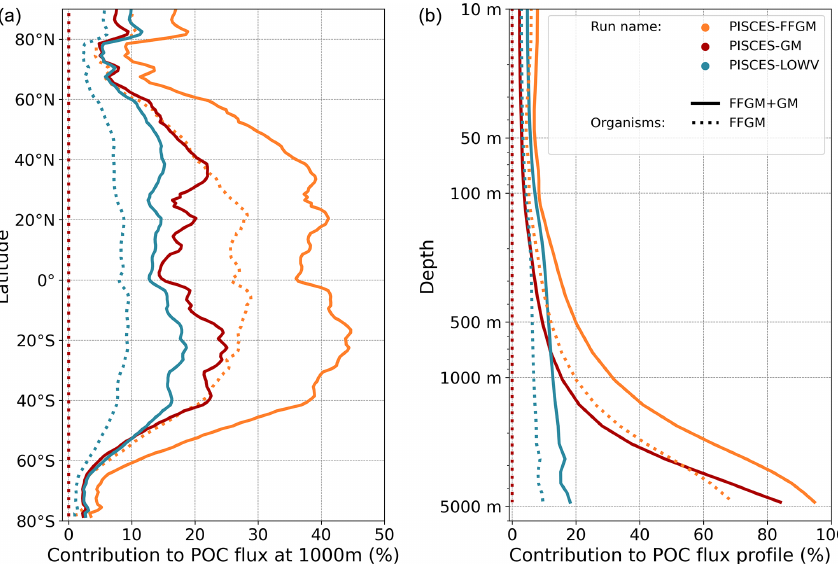
Figure 7. Macrozooplankton relative contribution to particulate organic carbon fluxes. The color indicates the PISCES configuration consid- ered (see sensitivity section); (a) shows the relative contribution of FFGM (dash) and macrozooplankton (FFGM + GM, solid) to the POC export at 1000m averaged zonally; (b) shows the globally averaged vertical profile of these relative contributions.